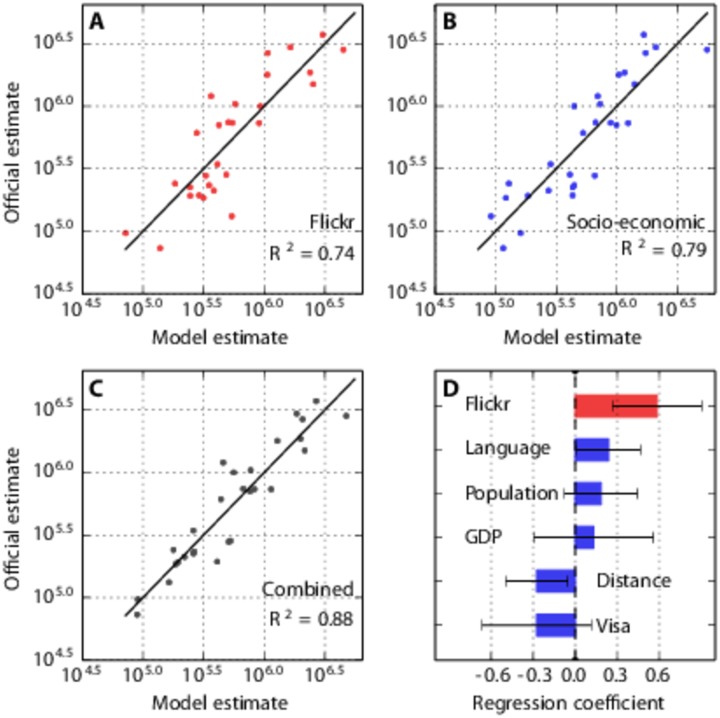
Comparison of estimates of the number of visitors to the UK using standard socio-economic indicators, and estimates using Flickr data.We analyse data for all 28 countries of origin depicted in Fig 1, from 2008 to 2013. (A) Estimates of the average number of visitors per year to the UK, generated by a regression model using the detected number of Flickr users visiting the UK only. (B) Estimates generated using five socio-economic indicators, namely whether the country of origin has English as an official language, the population of the country, the GDP per capita of the country, the distance between the largest city in the country and London, and the stringency of UK visa requirements for citizens of the country. (C) Estimates generated by a combined model, using both Flickr data and the socio-economic indicators. We find that the combined Flickr and socio-economic model significantly outperforms both the Flickr model (F(5,21) = 4.75, p < 0.005) and the socio-economic model (F(1,21) = 14.57, p < 0.005). (D) In the combined model, regression coefficients for Flickr, language and distance are significantly different from 0. Error bars indicate 95% confidence intervals.